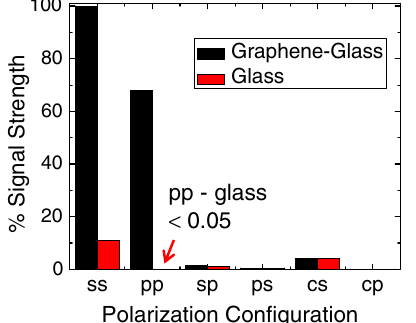
FIG. 3. Relative signal levels at various THG polarization combinations normalized to the s -in/ s -out signal levels of the graphene-glass system, which confirm the third-order nonlinear optical response of